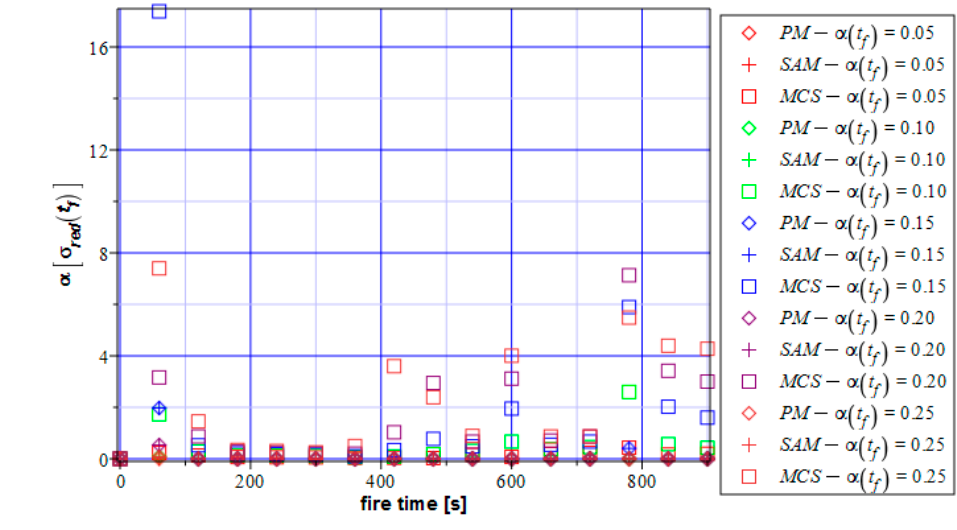
Figure 16. Coefficient of variation of the reduced stress.